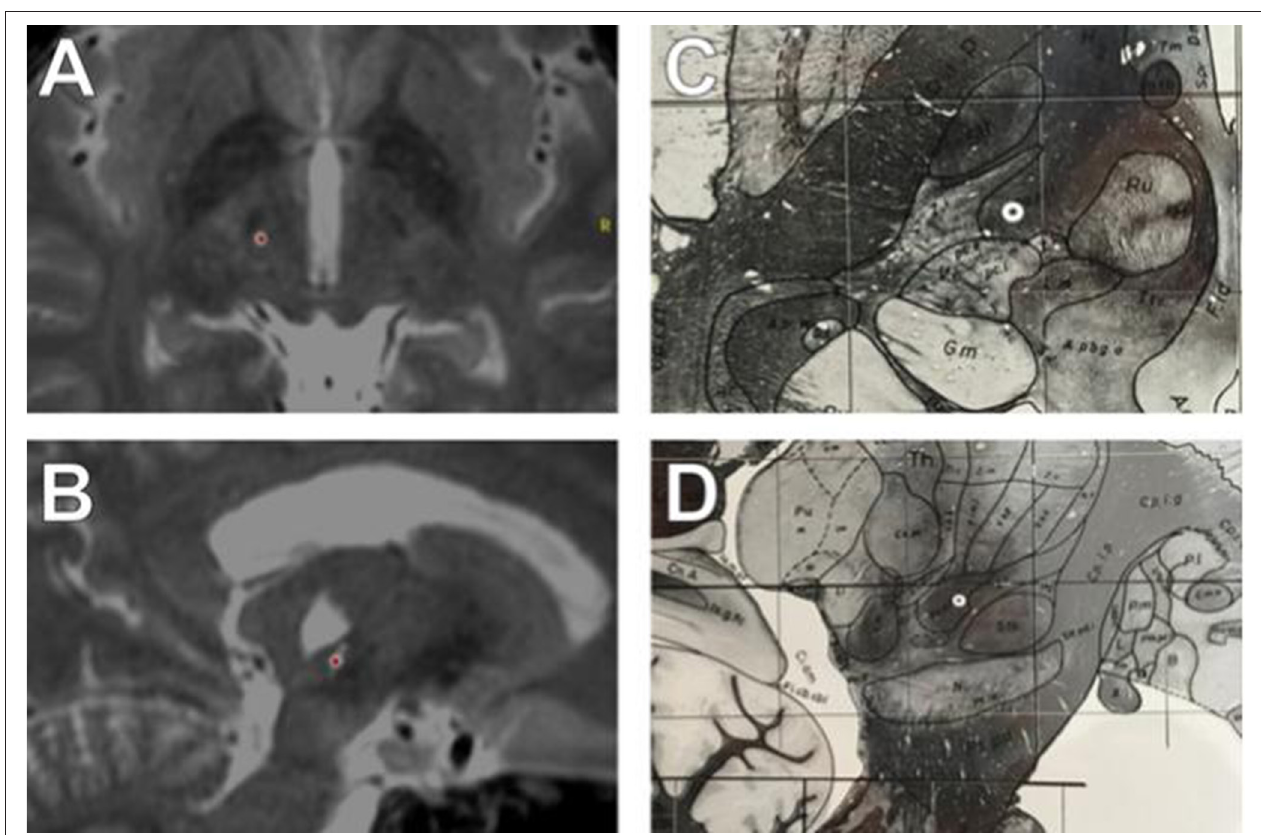
FIguRe 1 | T2 MRI of electrode implantation site, axial (a) and sagittal (B) views. Target location on the Schaltenbrand and Wahren atlas (12) in axial (C) and saggital (D) views. Schaltenbrand G, Wahren W (12) Atlas for stereotaxy of the human brain. Stuttgart: Thieme. T2-SPACE MRI, merged with intraoperative CT imaging. (a–B) . The electrode is marked with a red dot. AC/PC coordinates were (Lat: −11, A-P: −5, Vert: −1.5). (a) Axial view, contact 1. Note STN is visible anterior to electrode location, with analogous relative location noted in C. (B) Sagittal view, contact 1. Note the electrode location on the sagittal view relative to STN in B, and D. Note also the large cystic lesion superior to the electrode within the thalamus. Electrode location, Schaltenbrand and Wahren atlas, with electrode location marked based on AC/PC coordinates (white circle). (C) Electrode location in axial plane (Plate 54, H.v −1.5). (D) Electrode location in the sagittal plane Schaltenbrand and Wahren, (Plate 44, S.l.